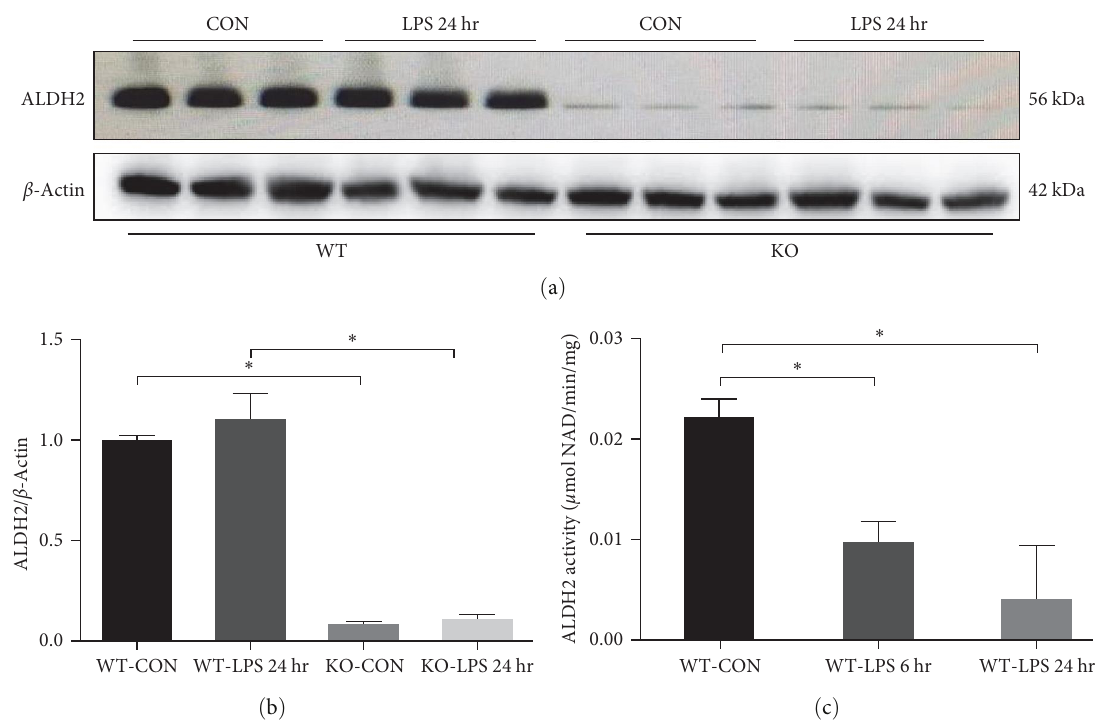
F IGURE 1: ALDH2 expression in kidneys at 24hr after LPS treatment in wild-type (WT) and ALDH2 knockout (KO) mice and ALDH2 activity at 6 and 24 hr after LPS treatment in WT mice; (a, b) representative western blots and quanti fi cation analysis of ALDH2 and β -actin (loading control); (c) quanti fi cation of ALDH2 enzymatic activity in kidneys at 6 and 24hr after LPS treatment in WT mice. All data are shown as mean Æ SEM ( n = 6). ∗ P < 0 :